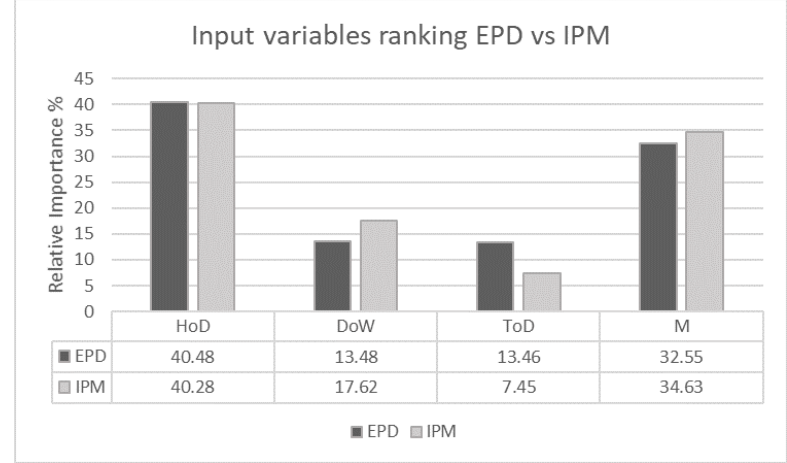
Figure 14. Relative importance in % to the joint response (demand and price of electricity) of calendar variables (HoD, DoW, ToD and M) using the VIT, EPD and